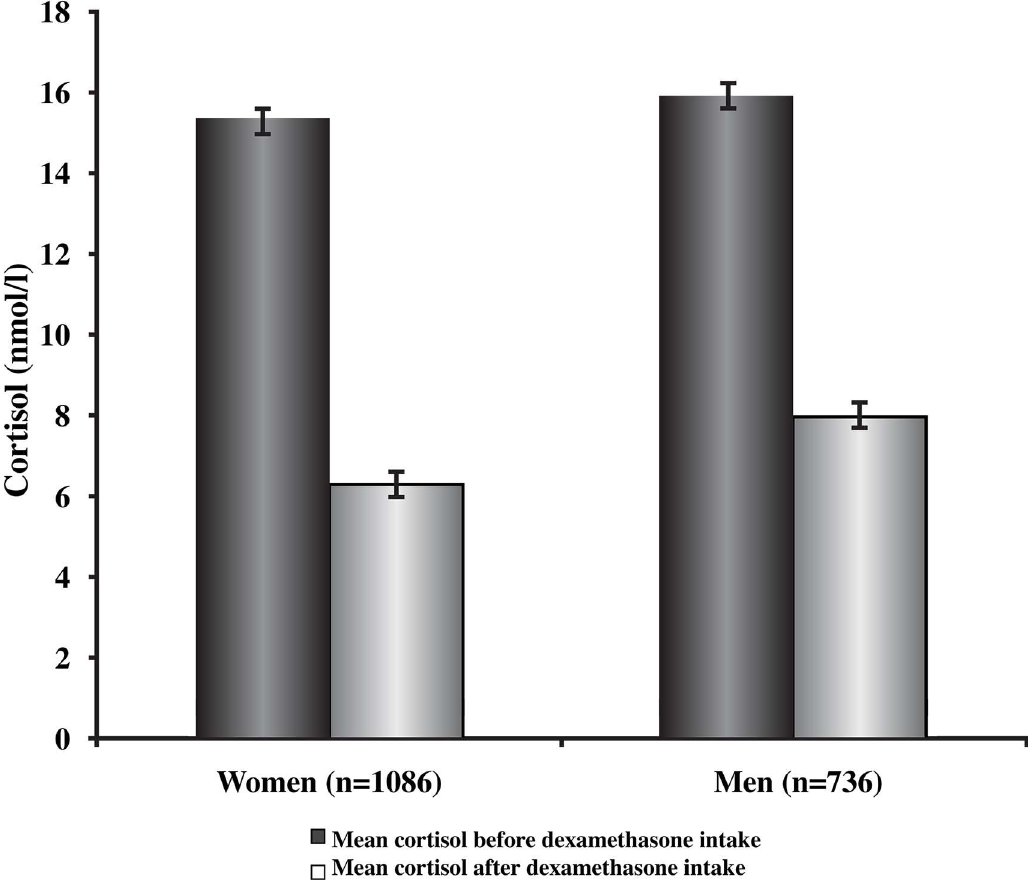
Fig 1. Cortisol concentrations before and after dexamethasone intake. Cortisol concentrations were significantly lower after dexamethasone intake in both men ( p < .001) and in women ( p < .001). The differencein cortisol concentrations before dexamethasone intake between women and men were not significantly different ( p = .23). In contrast, there was a significant difference in cortisol concentrations after dexamethasone intake between women and men ( p <